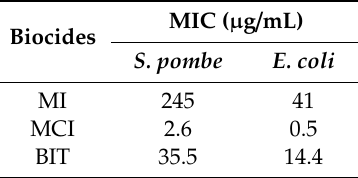
Table 1. Minimum growth inhibitory concentration (MIC) values of MI, MCI, and BIT against